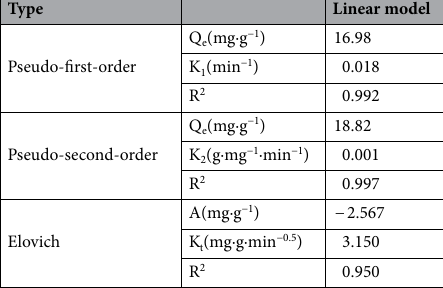
Table 2. Fitting parameters of adsorption kinetics of BC-HA adsorption of Ni(II) ions.